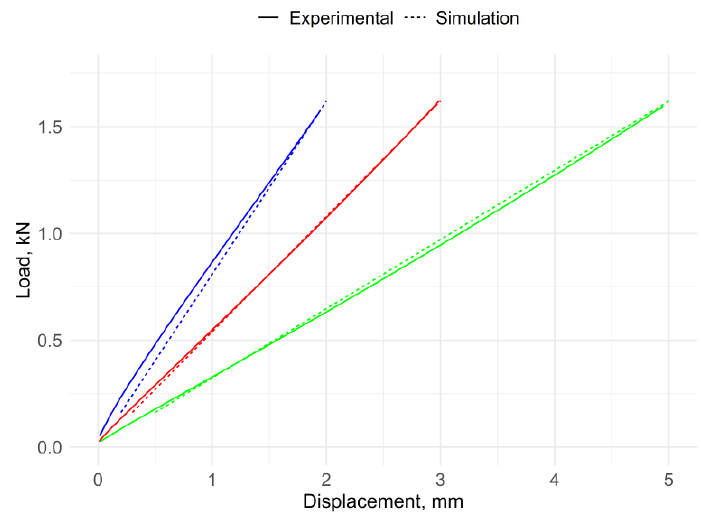
Figure6. Comparisonbetweenexperimentalandsimulationresultsfordifferentshapefactors: 0.75(blue), Figure 6. Comparison between experimental and simulation results for different shape factors: 0.75 0.5 (red) and 0.3 (blue), 0.5 (red) and 0.3 (green).